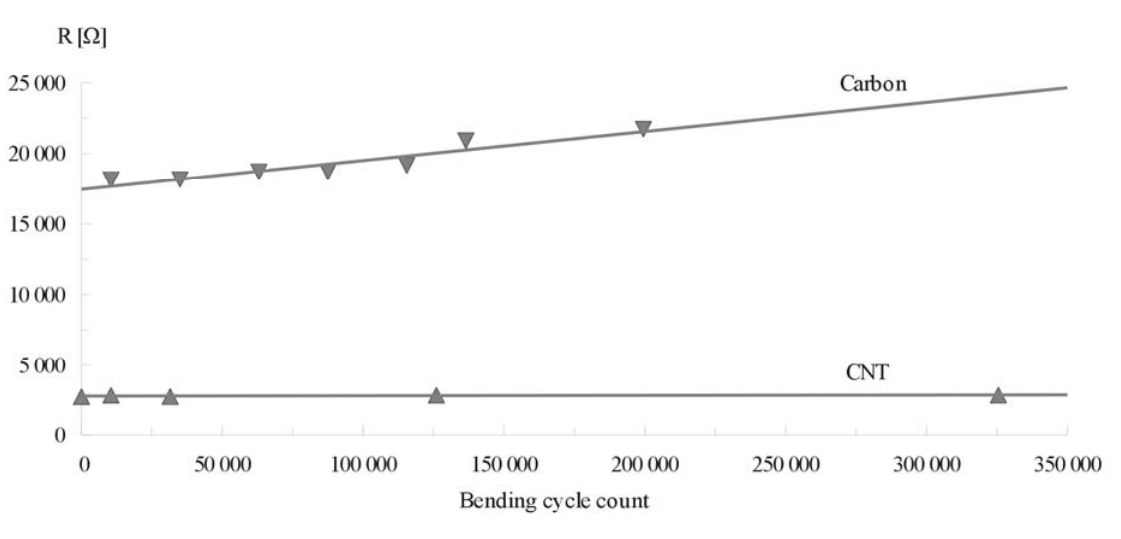
Figure 6. Resistance change of test stripes printed from nanotube-polymer and graphite-polymer compositions during cyclical